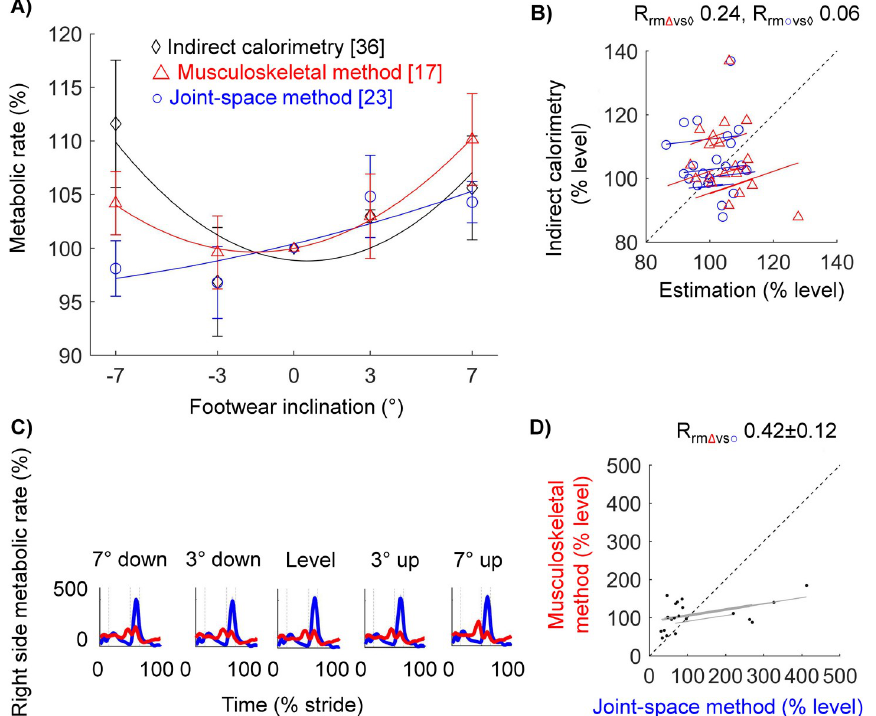
Fig 7. Estimations of the stride average metabolic rate and the time profile of metabolic rate during walking on a level grade with different shoe inclinations. (a) Stride average metabolic rate. Red triangles, blue circles, and black diamonds indicate the results from the musculoskeletal estimation method, the joint-space estimation method, and indirect calorimetry, respectively. Error bars indicate s.e.m. The average trends across conditions from the same method are shown as a solid line from a second-order polynomial curve fit. (b) Individual stride averages. Symbols are individual trials. Lines are individual fits from the repeated measures correlation test. Slopes that are less or more steep than a slope of 1/1 indicate overestimation or underestimation, respectively. R rm -values indicate the repeated measures correlation. (c) Time profiles under different shoe inclination conditions. Red and blue lines indicate the results from the musculoskeletal estimation and joint-space estimation methods, respectively. Strides are segmented from the ipsilateral heel strike to the next ipsilateral heel strike. The shaded area indicates s.e.m. (d) Individual phase averages. Symbols are averages of the phases during the level walking condition separated by vertical lines: first double support (from ipsilateral heel strike to contralateral toe-off), single support, second double support (from contralateral heel strike to ipsilateral toe-off), and swing phase. R rm -values indicate mean ± s.e.m. of the repeated measures correlations of the different walking conditions.